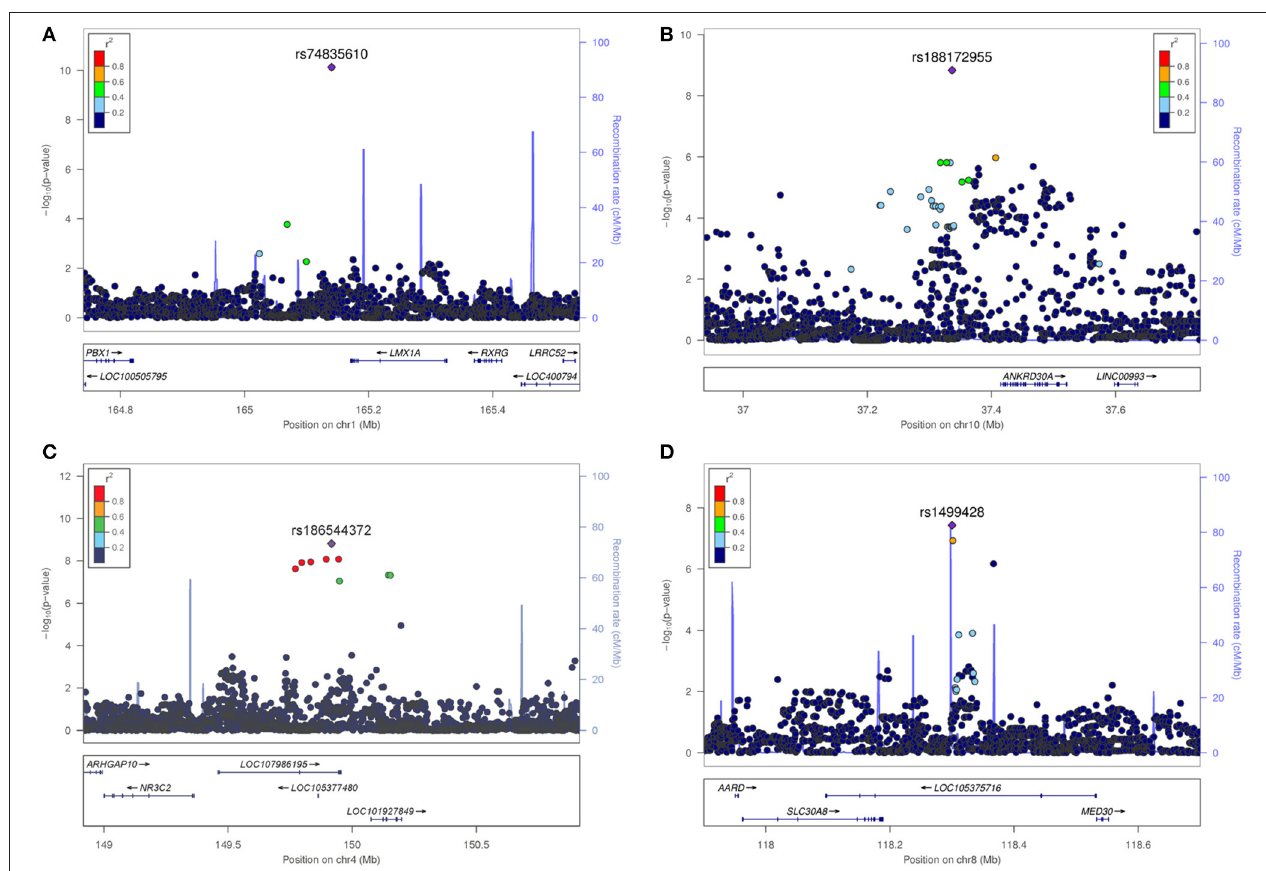
FIGURE 4 | Regional association plots for the four novel vestibular neuritis loci. In order to highlight the statistical strength of the association in the context of the surrounding markers, gene annotations and estimated recombination rates (NCBI build 37) of the SNVs in the specific regions are plotted against their corresponding P -values (as –log 10 values, left-hand y-axis). A purple diamond represents the SNV with the highest association signal in each locus. All other variations are represented as single dots, where dot colors indicate the LD with the associated SNV. Color coding represents the r 2 value and respective categories are shown on the upper left hand side. Estimated recombination rates (cM/Mb) are plotted to reflect the local LD structure surrounding the associated SNV and are shown as vertical light blue lines, marked on the right-hand y-axis. Genes in the region are displayed below. Orientation of the genes is indicated by arrows. (A) LMX1A. Regional association plot of rs74835610 on chromosome 1q23.3. This genome-wide associated SNV (purple diamond) is localized 30kb from LIM homeobox transcription factor 1 alpha (LMX1A). No additional variations in high LD or with low P -Values are present in this region. (B) ANKRD30A. Regional association plot of rs188172955 on chromosome 10p11.21. This genome-wide associated SNV (purple diamond) is localized 78kb from ankyrin repeat domain 30A (ANKRD30A). Additional variations in LD (r 2 between 0.2 and 0.8) surround this SNV but fail to reach genome-wide significance. (C) NR3C2. Regional association plot of rs186544372 on chromosome 4q31.23. The most significant SNV in this region as well as five other genome-wide associated SNVs in high LD ( r 2 > 0.8, red dots) are localized on a predicted long ncRNA (LOC107986195). The next coding gene, nuclear receptor subfamily 3 group C member 2 gene (NR3C2) is localized in 100kb distance. (D) SLC30A8/MED30. Regional association plot of rs1499428 on chromosome 8q24.11. This genome-wide associated SNV (purple diamond) is localized in the intronic regions of two overlapping ncRNAs (LOC105375717, LOC105375716). The next coding genes are solute carrier family 30 member 8 (SLC30A8) and mediator complex 30 (MED30).